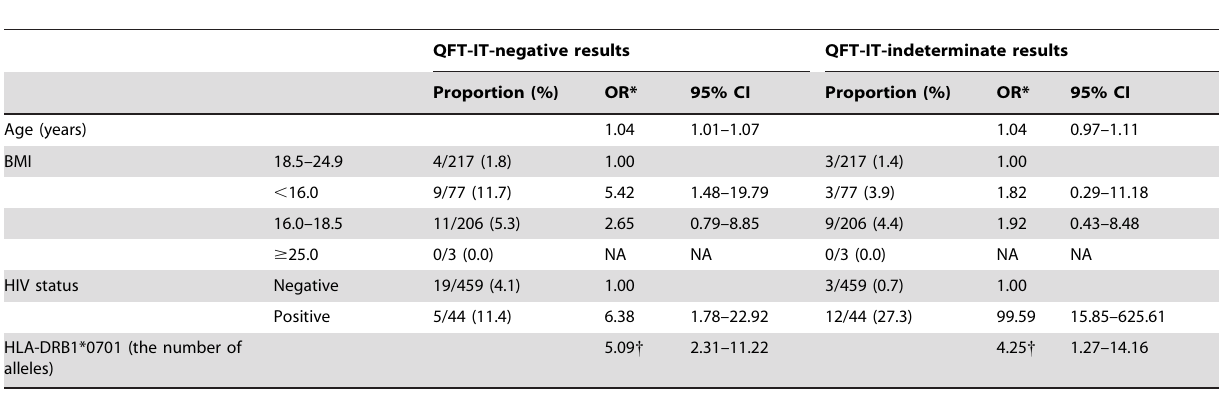
Table 5. Multivariate analysis using polytomous logistic regression model for factors associated with QFT-IT-negative and - indeterminate results